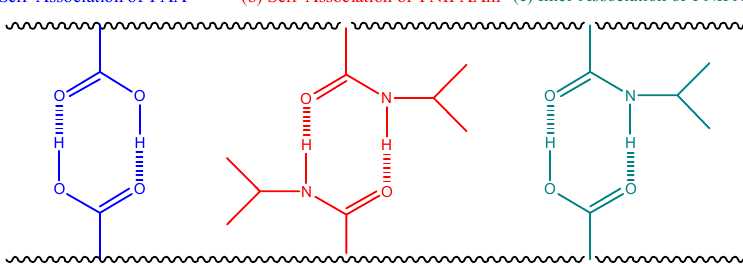
Scheme 2. Noncovalent interactions of PNIPAm- co -PAA copolymers: ( a ) self-association of PAA units; ( b ) self-association of PNIPAAm units; and ( c ) inter-association of PNIPAAm- co